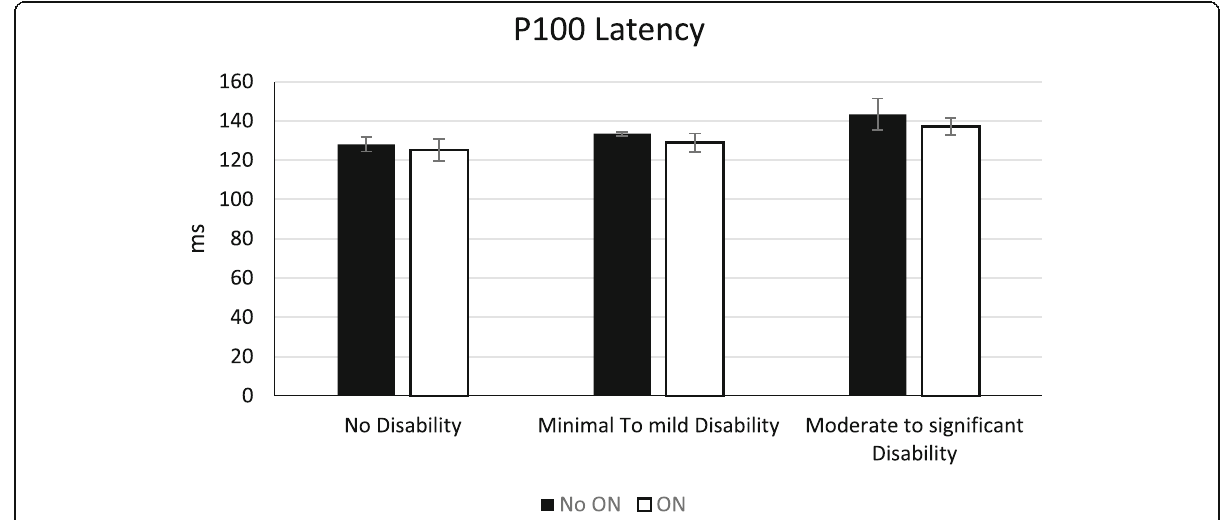
Fig. 1 Mean P100 latency in the 3 patient groups with history of optic neuritis (ON) and without history of optic neuritis (No ON)